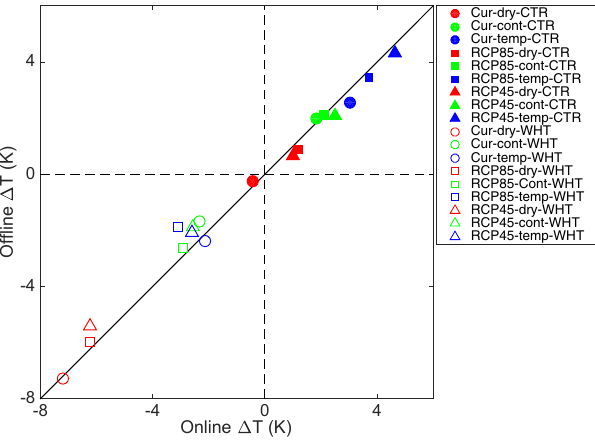
Figure 2. Scatter plot between the daytime UHI intensity computed online with the CLM and that calculated offline using the surface energy balance diagnostic data. Filled and open symbols denote re- sults from control (CTR) and white roof (WHT) simulations, re- spectively. Red, green, and blue colors denote dry (dry), continental (cont) and temperate (temp) climate regions, respectively. Circle, triangle, and square symbols denote current climate (cur), RCP4.5 (RCP45), and RCP8.5 (RCP85) scenarios,